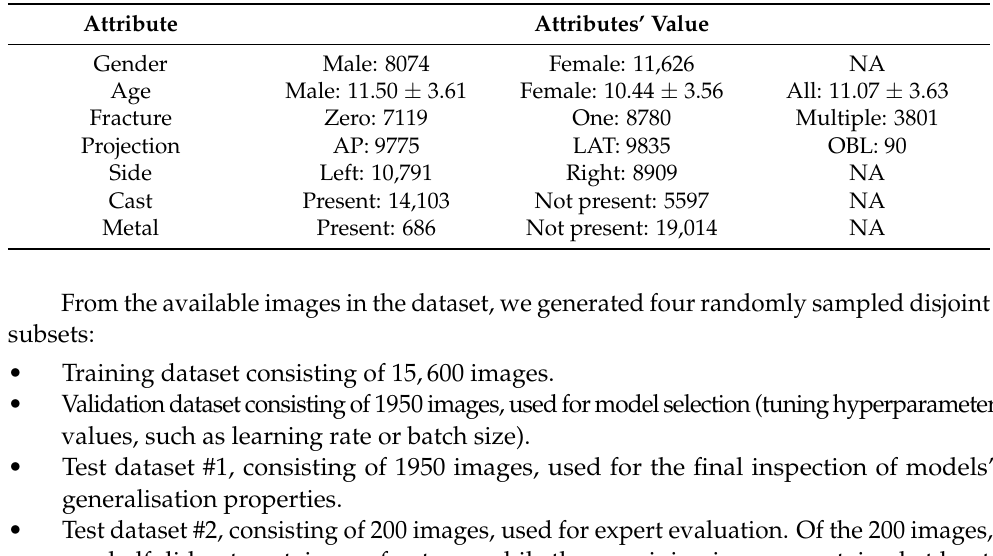
Table 1. Dataset